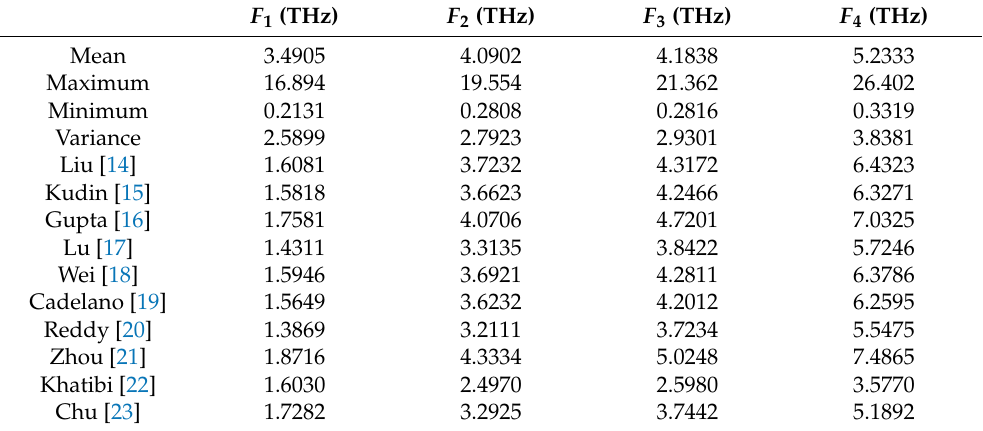
Table 2. The statistic results of resonant frequency in the finite plane element model of graphene.